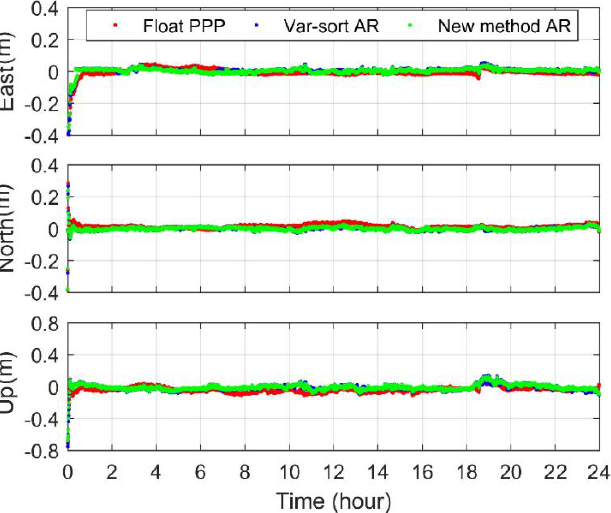
Figure 5. RMS of Kinematic PPP errors for three different directions at